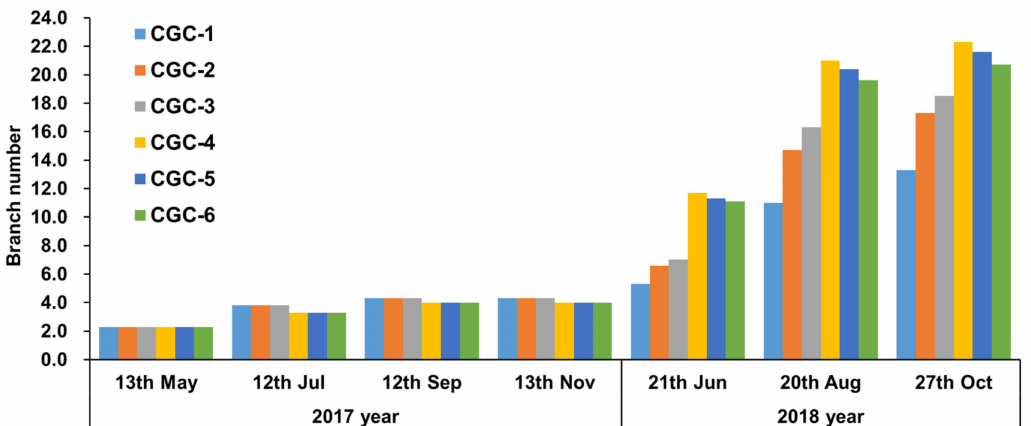
Figure2. Pinusdensiflora seedlingbranchnumbersaffectedbydifferentcontainergrowthconditions(CGCs). CGC-1: Control container without modification; CGC-2: CGC-1 with inside 5 mm thick root-turning bump; CGC-3: CGC-1 with inside 10 mm thick root-turning bump; CGC-4: negative phototropism container with a vertical striped slit made on the surface of CGC-1; CGC-5: CGC-4 with inside 5 mm thick root-turning bump; CGC-6: CGC-5 with inside 10 mm thick root-turning